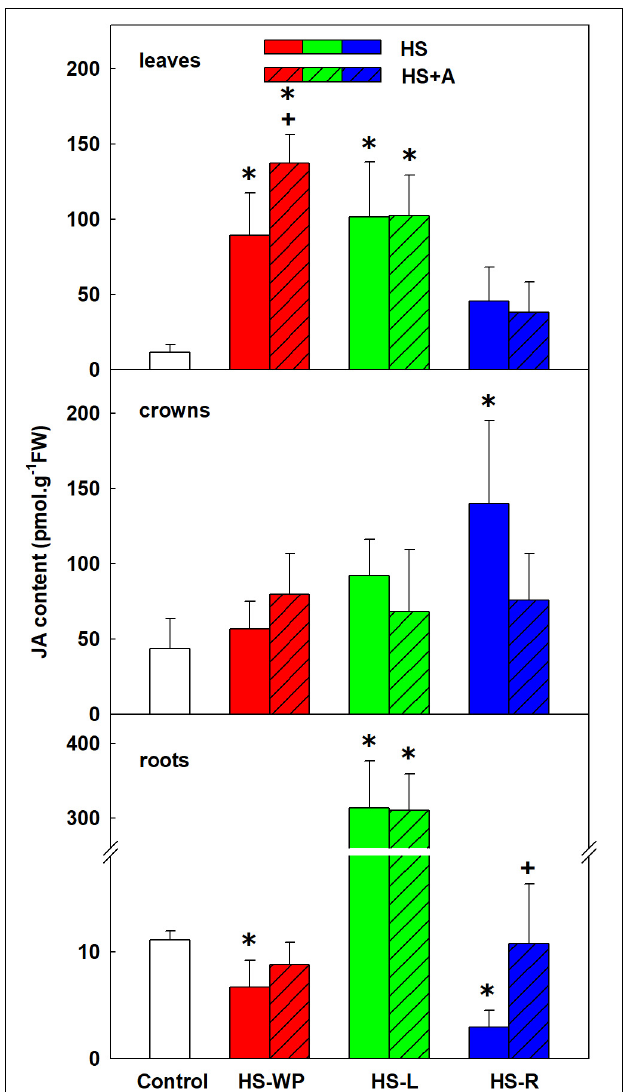
FIGURE 3 | The content of jasmonic acid (JA) in leaves, crowns and roots of rice seedlings exposed to heat stress directly (HS) or after acclimation (HS + A). Heat stress was applied to whole plants (HS-WP), to leaves (HS-L) or roots (HS-R). Data are means ± SD. One-way ANOVA with Tukey’s post hoc test ( p < 0.05, n = 6) was used to compare controls to the HS treatments. Significant differences compared to control plants are indicated by asterisks ( ∗ ) while crosses (+) indicate significant differences between HS and HS + A treatments.